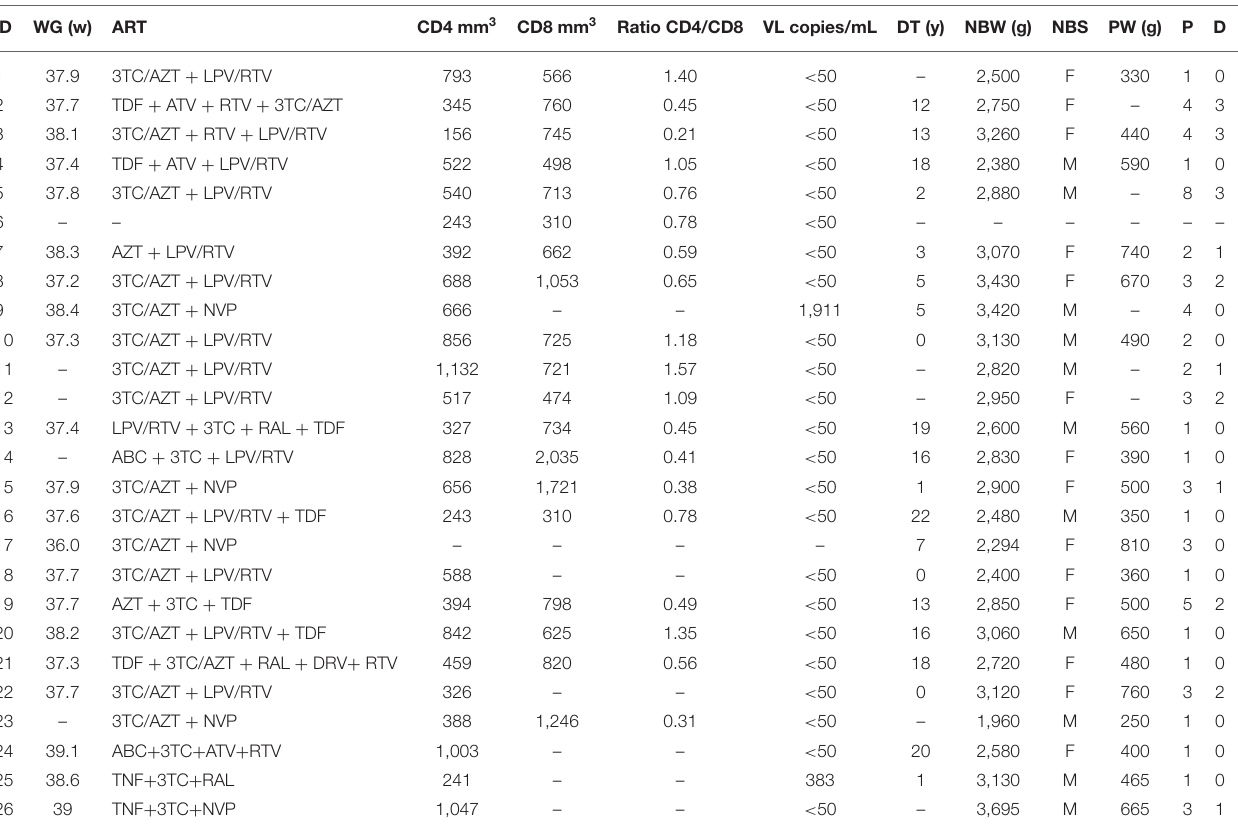
TABLE 1 | HIV-infected mothers